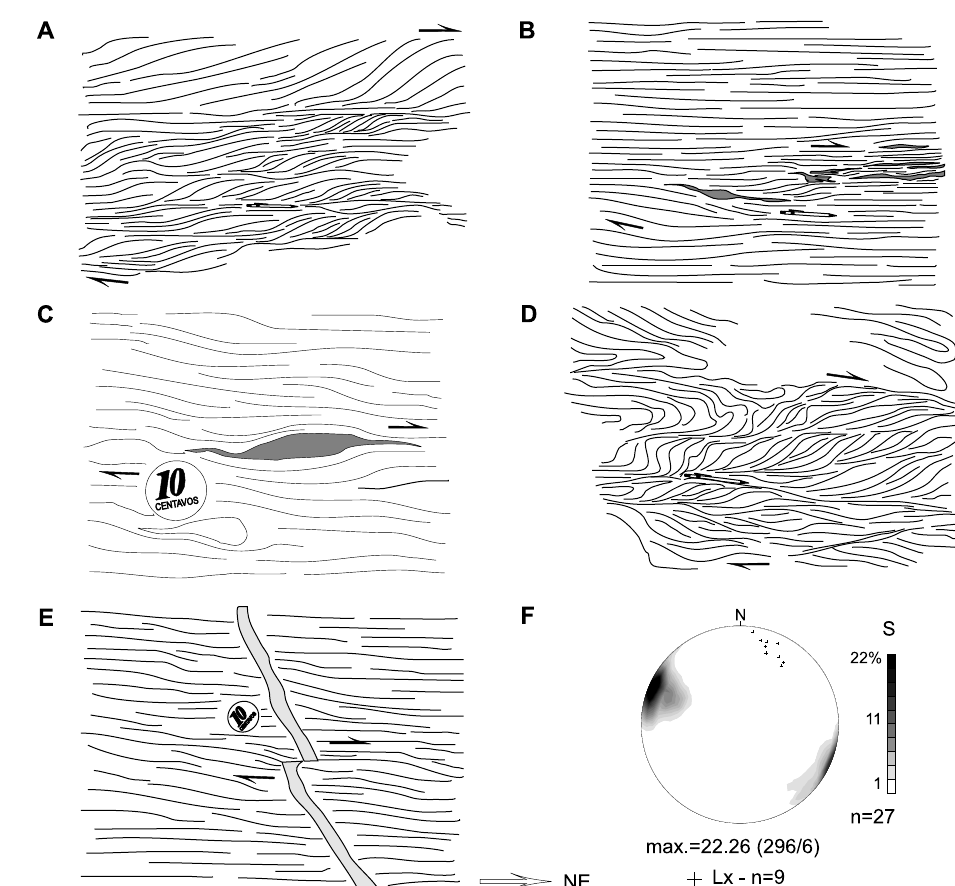
Fig. 8 – Dextral kinematic indicators in high-angle granulitic mylonites near the road junction at Bom Jesus do Itabapoana/RJ. Section parallel to the XZ plane of the finite strain ellipsoid with its direction identified. A – S-C fabric of the foliations; B – Mafic lenses parallel to the C and C´ planes (above the pencil); C – Sigmoid basic lens; D – S-C-C´ foliation pairs with interference fold patterns in the left-hand part; E – Quartz-feldspathic vein cut by a fault with centimetric reject; F – Stereographic projection of foliation planes (S) and stretching and mineral lineations (Lx). Number of data points (n)